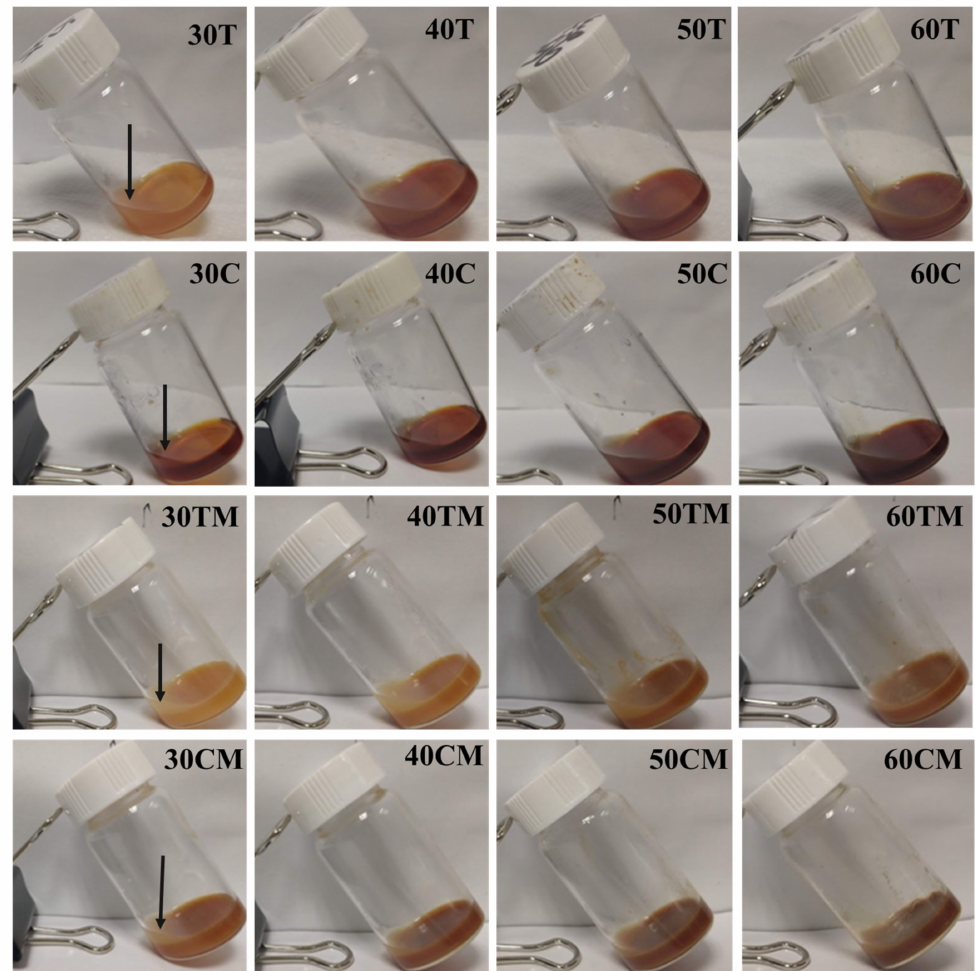
Figure 4. Physical observation of hydrogels after completion of the gelling period. Different hydrogels are shown here, incorporating tea or coffee with or without milk. The black arrow marks supernatant in the top layer of